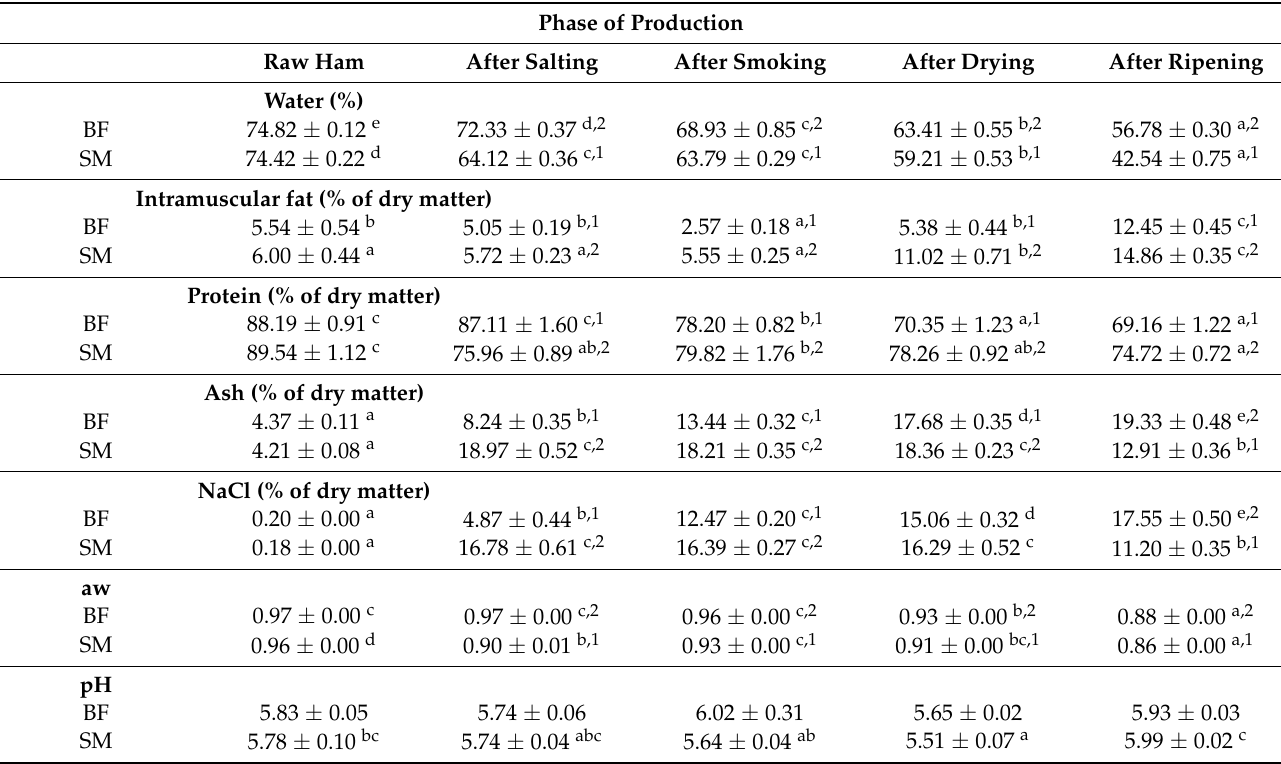
Table 1. Physicochemical parameters (expressed as mean ± standard error) in two muscles (biceps femoris (BF) and semimembranosus (SM)) during the manufacturing process of smoked dry-cured